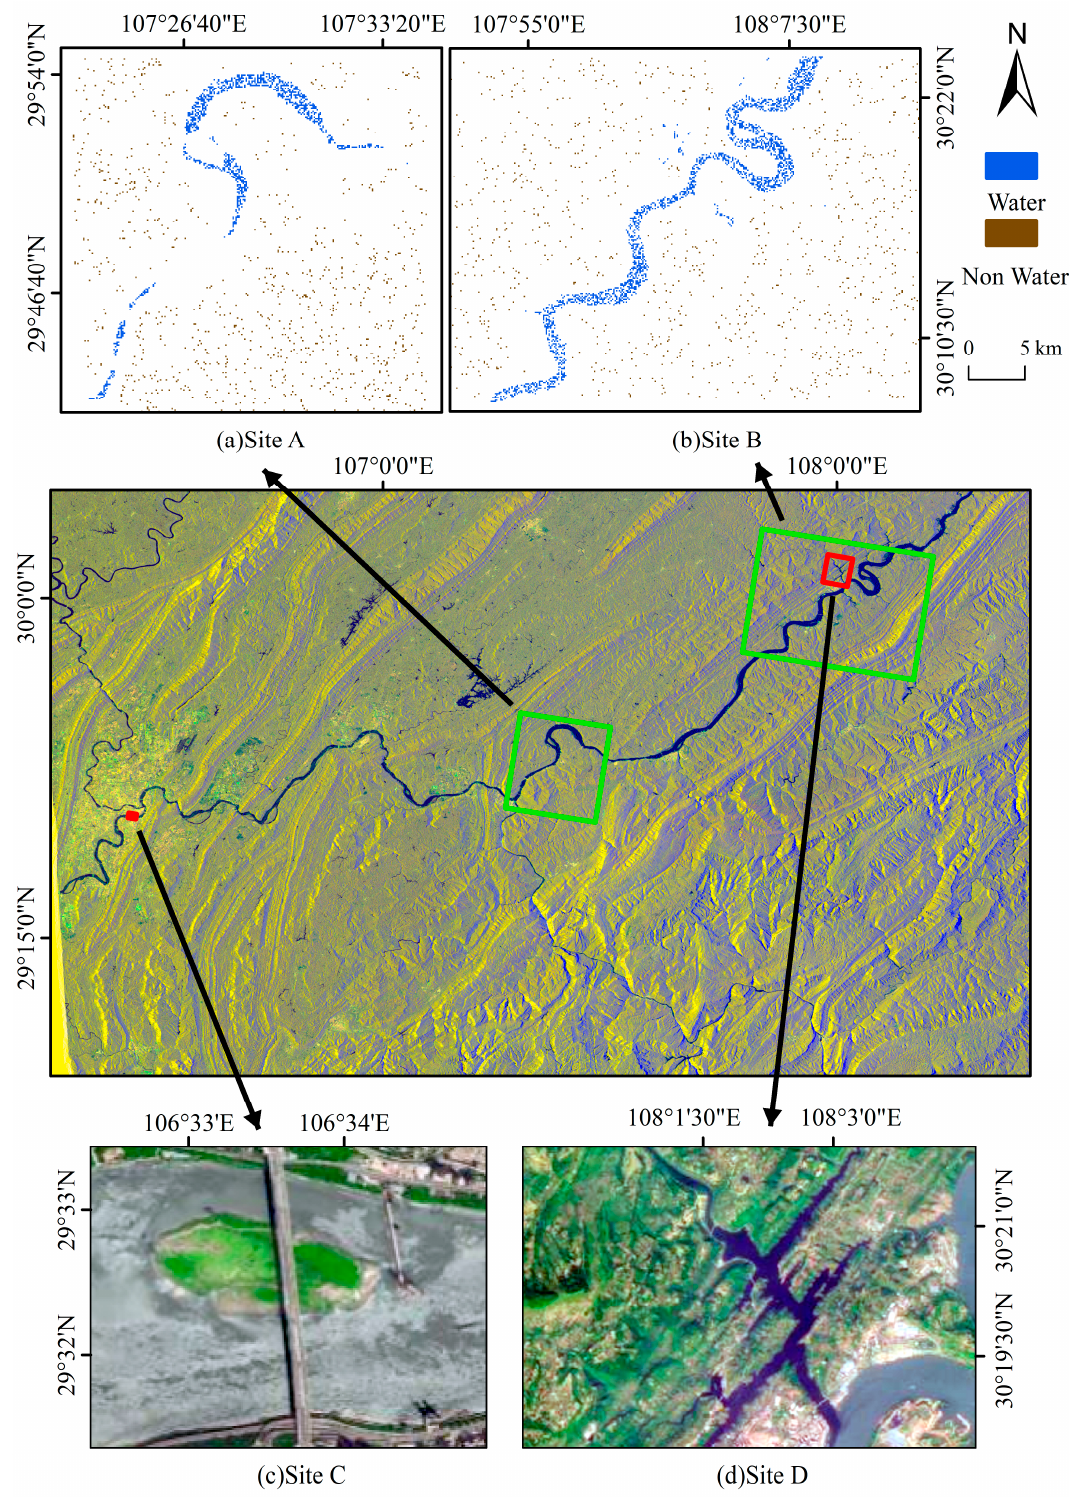
Figure 2. True color image of Sentinel-1 over the study area and four sub-regions for ( a ) Site A: model development and validation; ( b ) Site B: model transfer; and ( c ) Site C (Shanhuba) and ( d ) Site D (Huangjin River): monitoring the dynamic changes in water surface during the flood season in 2020.